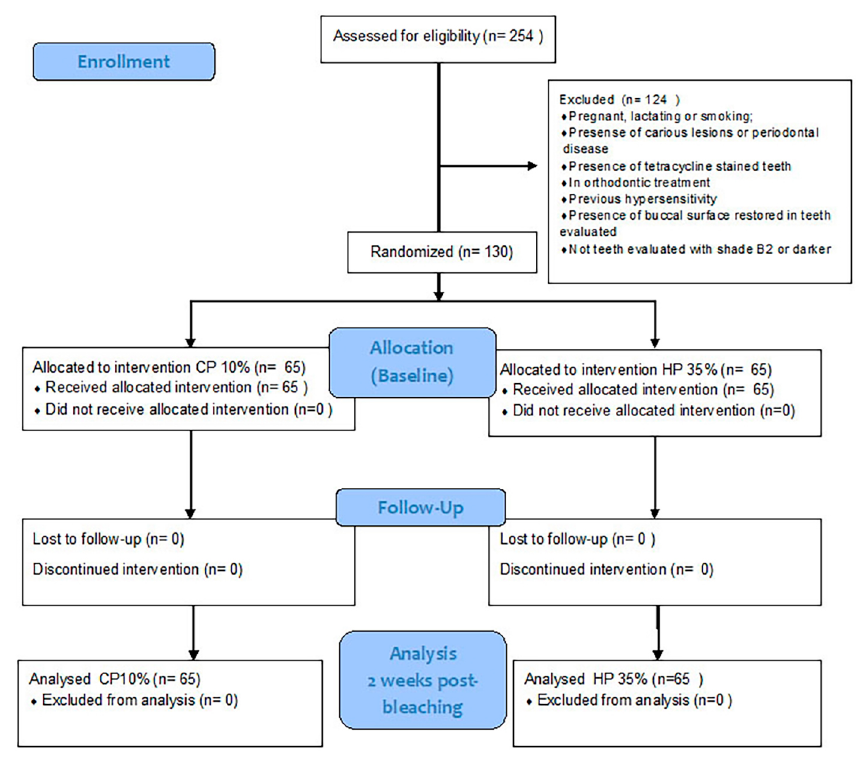
Figure 1- Flow-chart of the